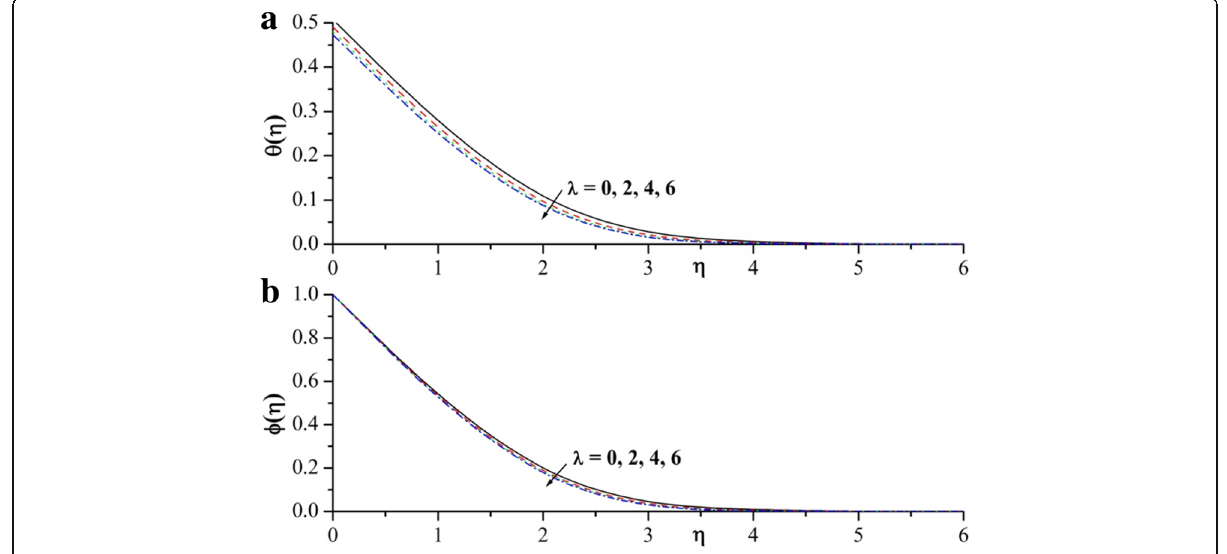
Fig. 5 a Temperature and b nanoparticle concentration profiles for variable values of